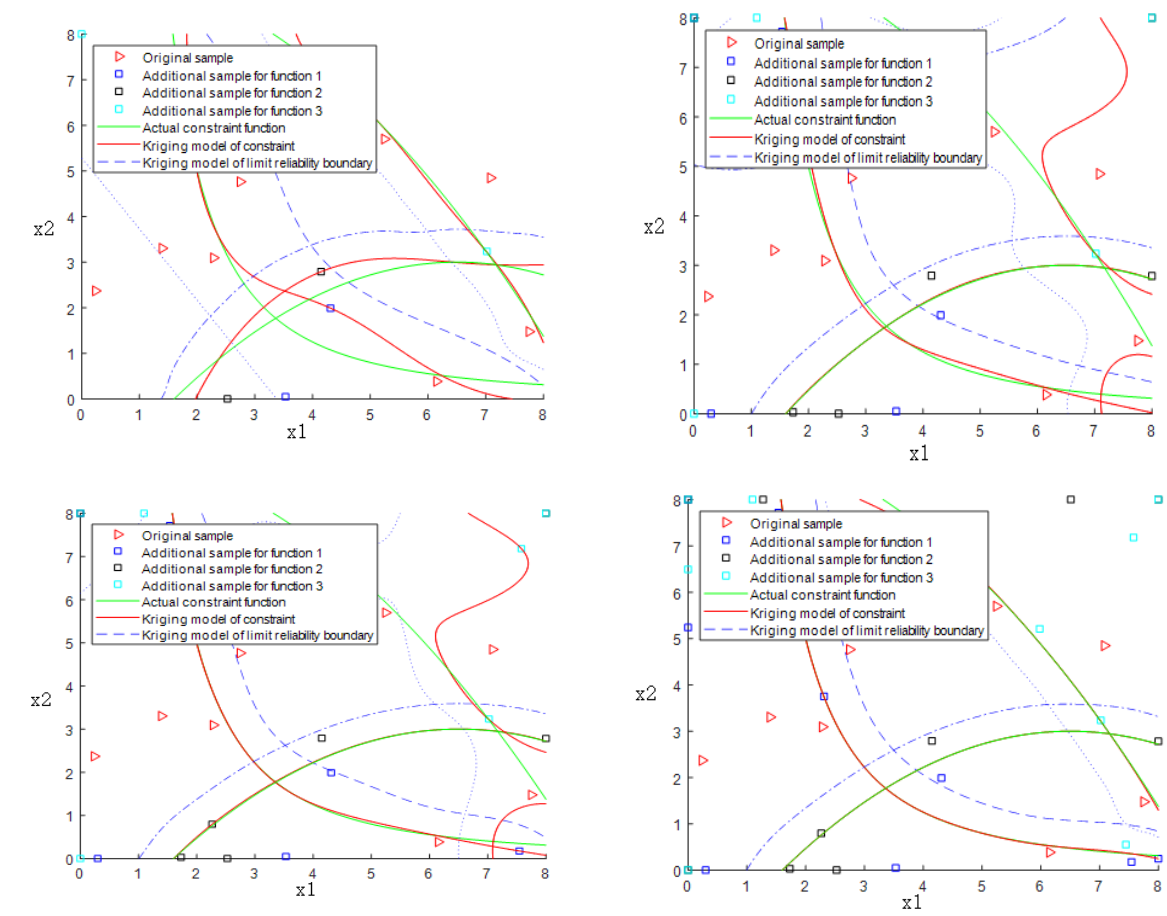
Figure 7. Optimization process of the Choi example.